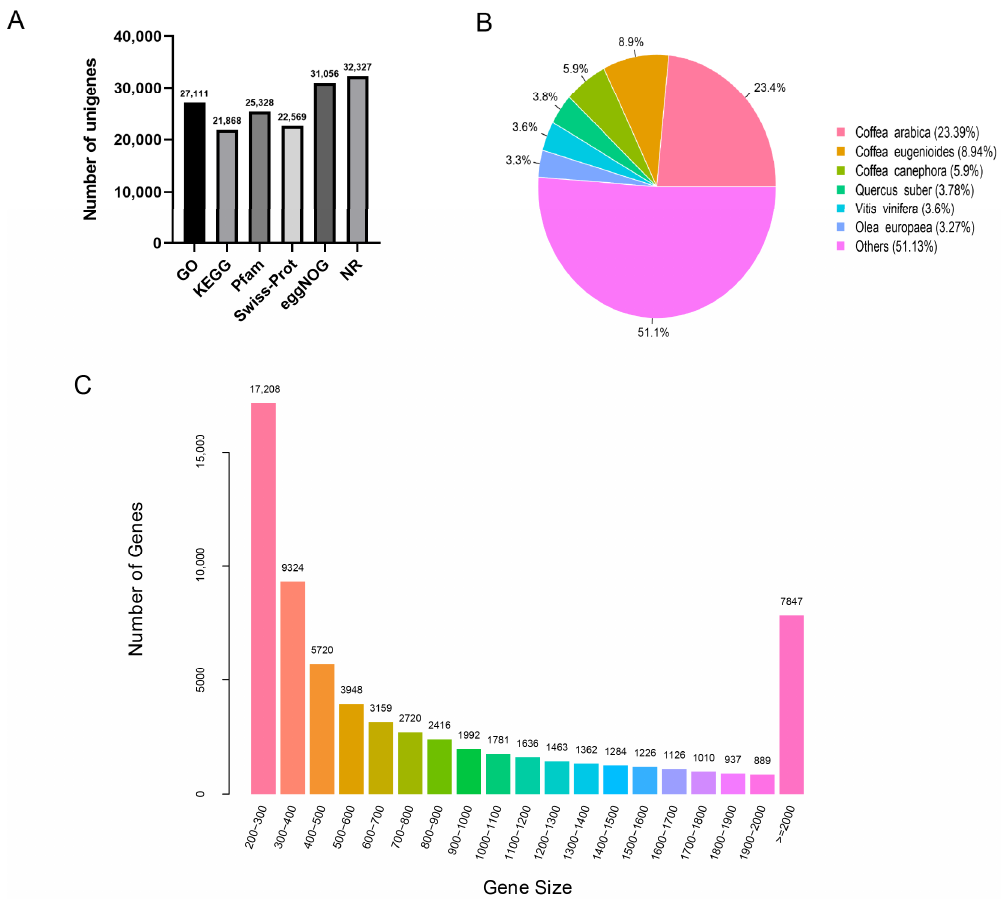
Figure 1. Illumina sequencing and transcriptomes of different tissues in G. macrophylla : ( A ) The annotation of unigenes based on various databases. ( B ) The species distribution of the annotated unigenes. ( C ) The detailed information of the assembled unigenes.